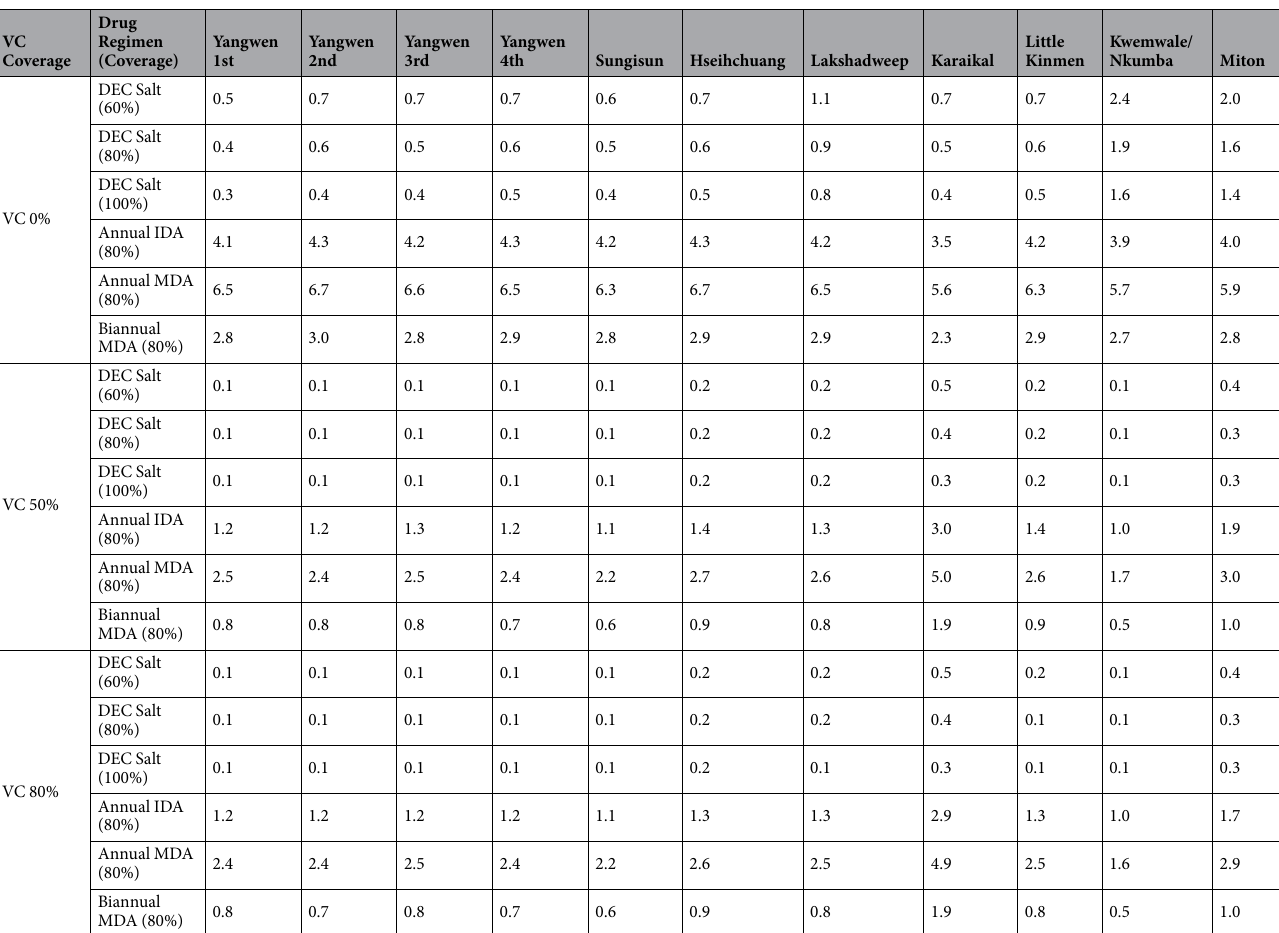
Table 1. Number of years of alternative interventions required to reach the site-specific 95% EP threshold after crossing the WHO 1% mf threshold. The estimated mean number of years required to reduce mf prevalence to the 95% probability mf breakpoint threshold under each intervention in a particular site are